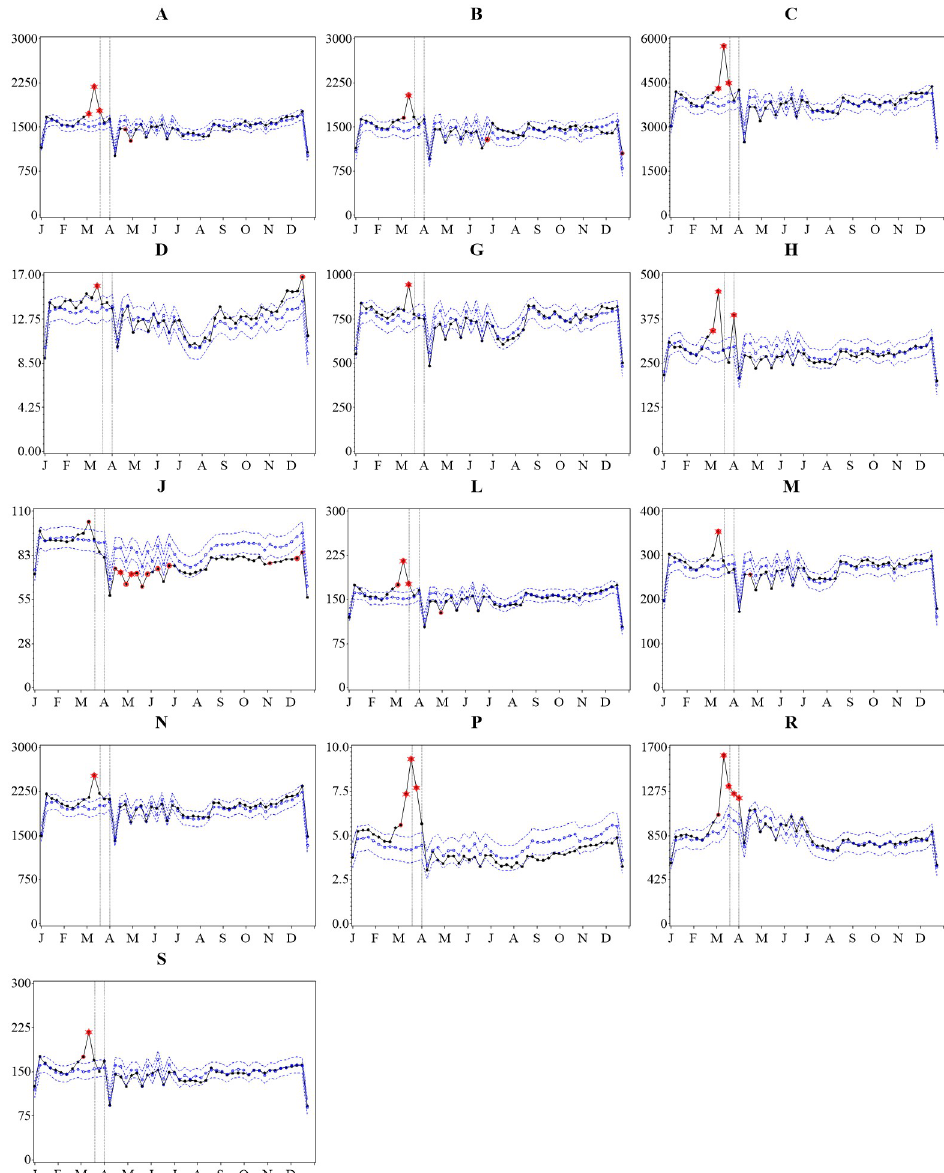
Fig 2. Observed versus predicted volume of dispensed defined daily doses of prescription medications per 1000 inhabitants by ATC anatomical main group, 2020, Sweden. Note: The vertical lines indicate the weeks containing March 19th and April 1st 2020 when limits on medication sales were recommended and then mandated, respectively. P-values that remain significant after Bonferroni correction are marked. Legend: solid black line = observed values; dotted blue line with open circles = predicted values; dotted blue lines, no marker = upper and lower 95% confidence limits; single red circle = 5% significance level; double red circle = 1% significance level; double red circle with star = 0.1% significance